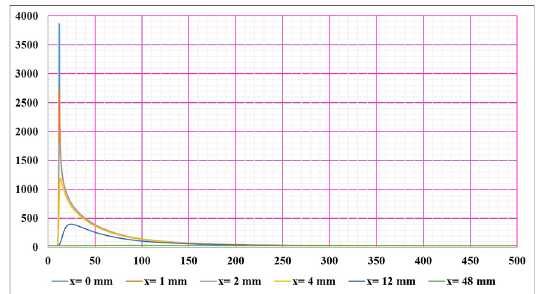
Figure 10. Temperature history at different locations when plasma torch is middle of the plate.